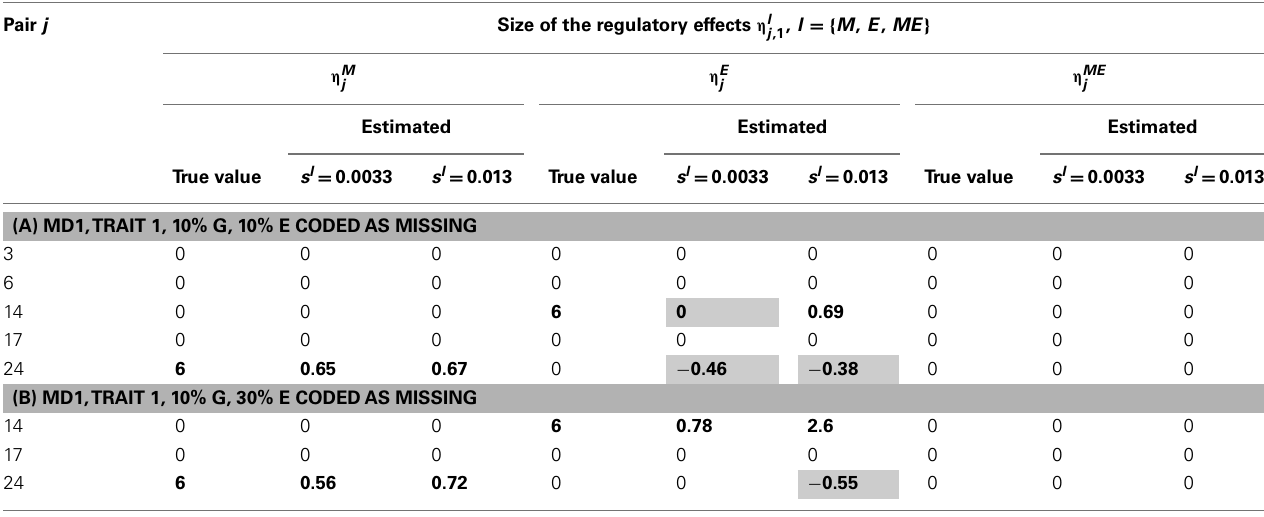
A bold font is used to indicate positions where the true or estimated effect was non-zero.The shaded cells indicate false positives and false negatives.